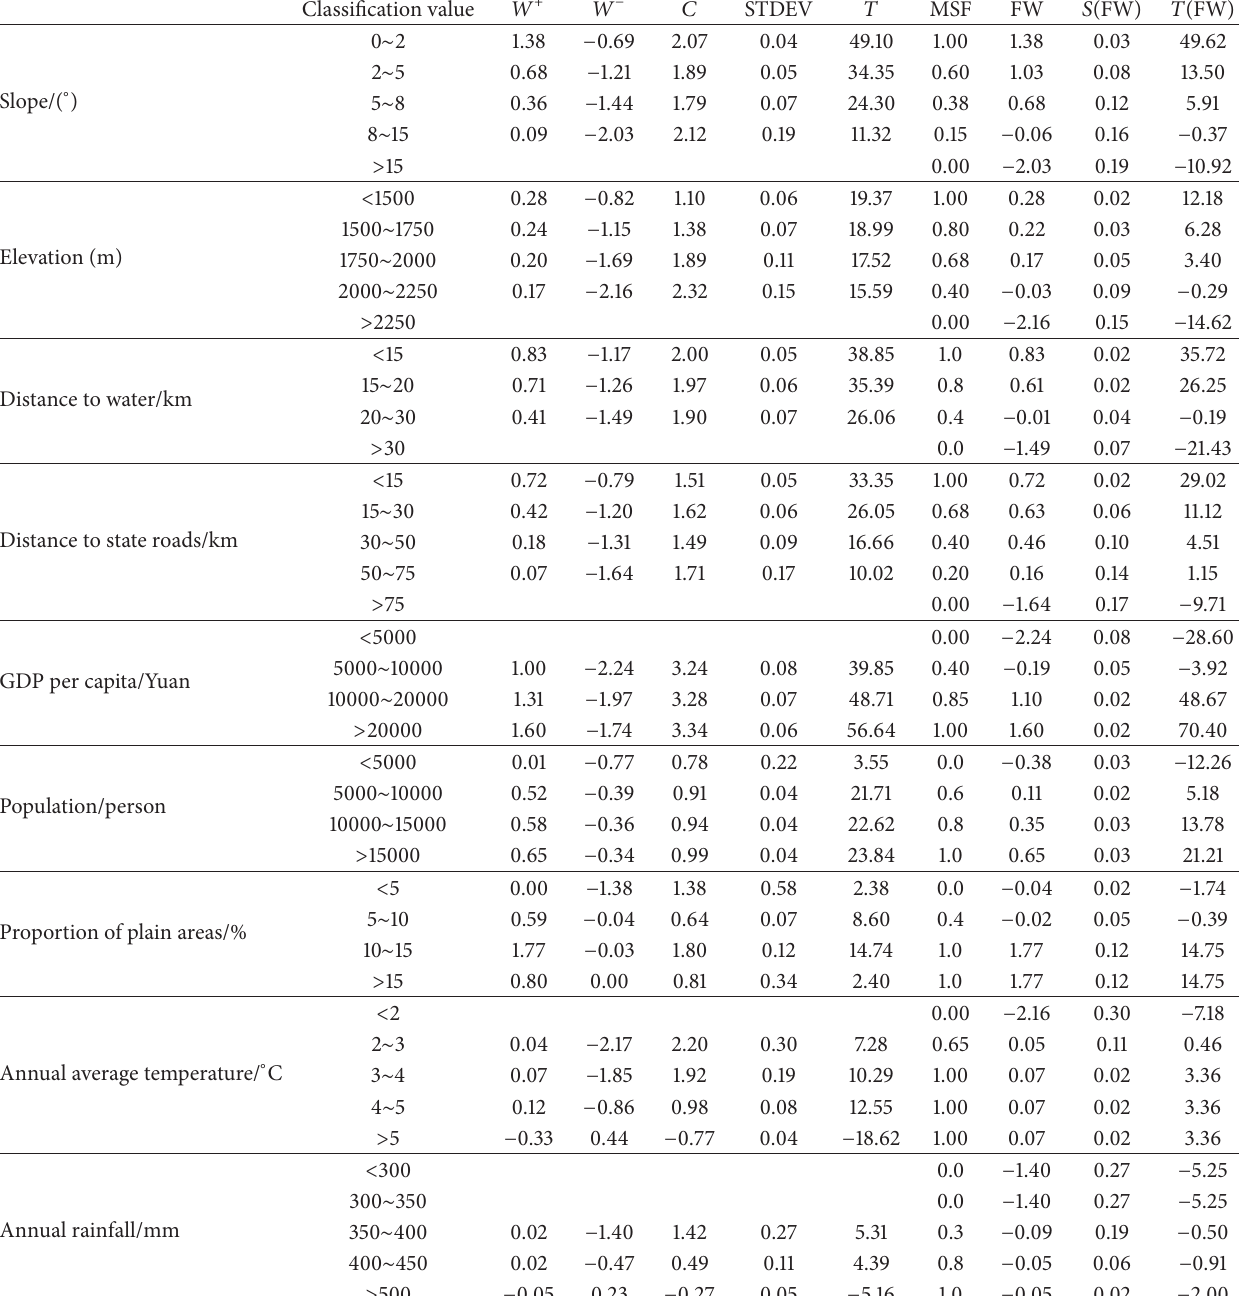
Table 1: Parameters of fuzzy weights of evidence for each map